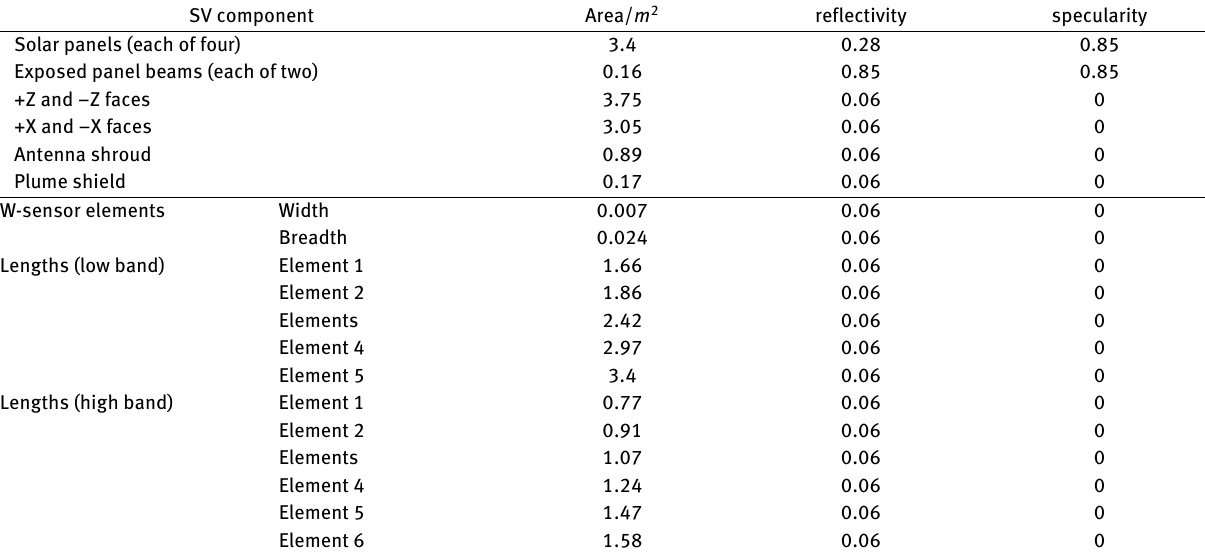
Table 1. Area and optical parameters of GPS Block IIR surfaces SV component Area/ m 2 reflectivity specularity Solar panels (each of four) 3.4 0.28 0.85 Exposed panel beams (each of two) 0.16 0.85 +Z and −Z faces